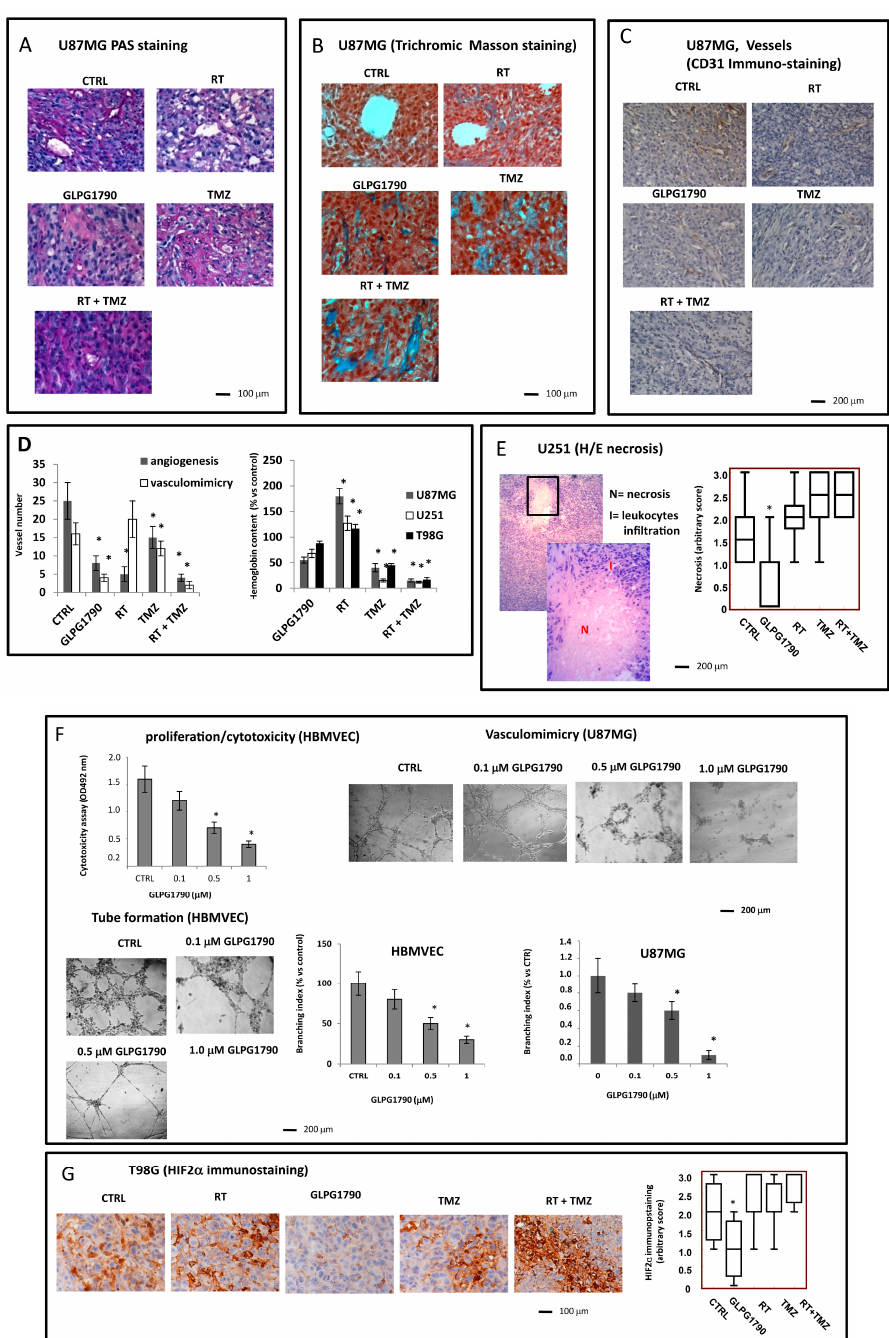
Figure 5. Histological evaluation of GLPG1790-treated xenografts: involvement of tumour microenvironment in the GLPG1790-mediated anti-tumour events. GBM xenografts contained giant cells, multinucleated cells and polygonal or spindle-shaped cells with abundant and intensely eosinophilic cytoplasm and hypochromatic nuclei. Areas with elevated tumour cell proliferation show a fibrillar collagen background that envelopes abundant vasculature and tumour cells. Deep changes in the quality of tumour microenvironment as modifications on: angiogenesis and vasculomimicry: ( A ) PAS staining; ( B ) trichromic Masson staining; ( C ) CD31 immunostaining; ( D ) vessel counts and hemoglobin content. ( E ) Necrosis, which is functionally associated to ( F ) increased in vitro cytotoxicity of HBMVEC, reduced in vitro vasculomimicry of U87MG cells and tubule formation of HBMVEC cells, as well as HIF2 α -immunostaining ( G ). * p <